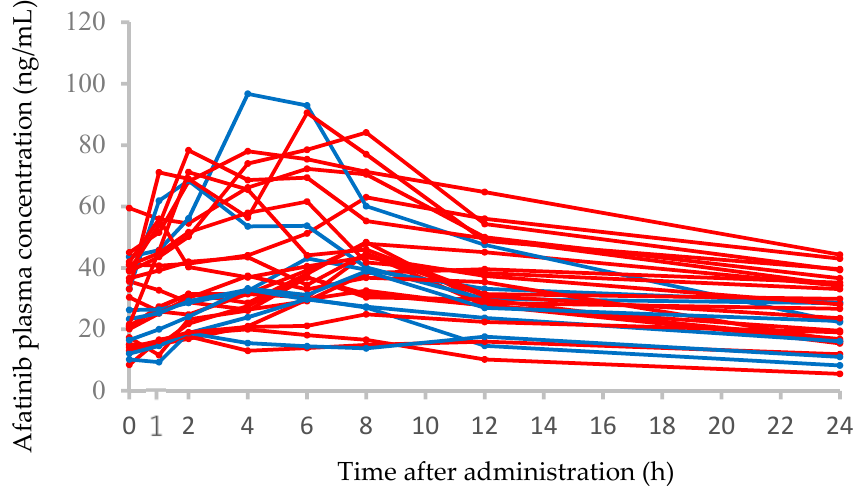
Figure 1. Plasma concentration–time profiles of afatinib in 28 patients administered afatinib at 30 mg/day (blue solid line) or 40 mg/day (red solid line). Table 2. Comparison and correlations of afatinib AUC 0–24 with clinical characteristics of patients.